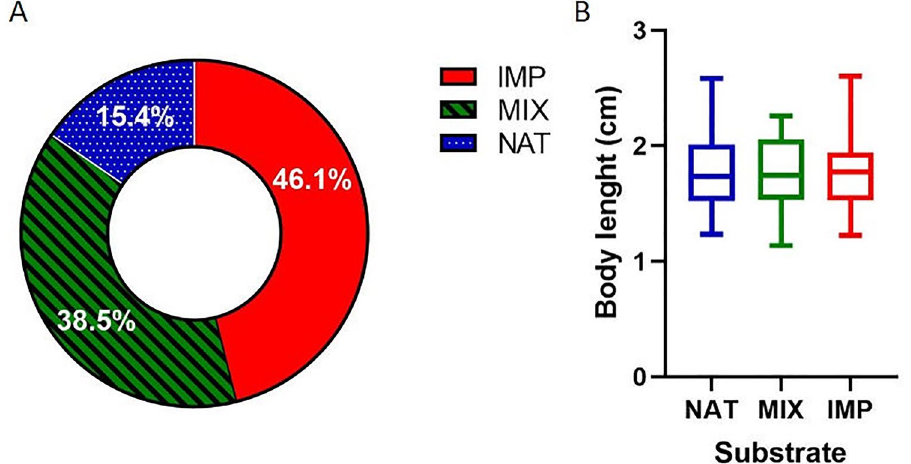
Figure 8. ( A ) Colonization of substrates by mayflies. ( B ) Body length for each substrate. Bars indicate 1–99 percentile in the box plot. NAT = natural substrate; lMP = PET, PP, PS (in equal proportions); MIX = NAT and lMP (50% each). The images ( A ) and ( B ) are obtained by the software GraphPad Prism (ver. 8.4.2, https ://www. graph pad.com/suppo rt/faq/prism -842-relea se-notes /).